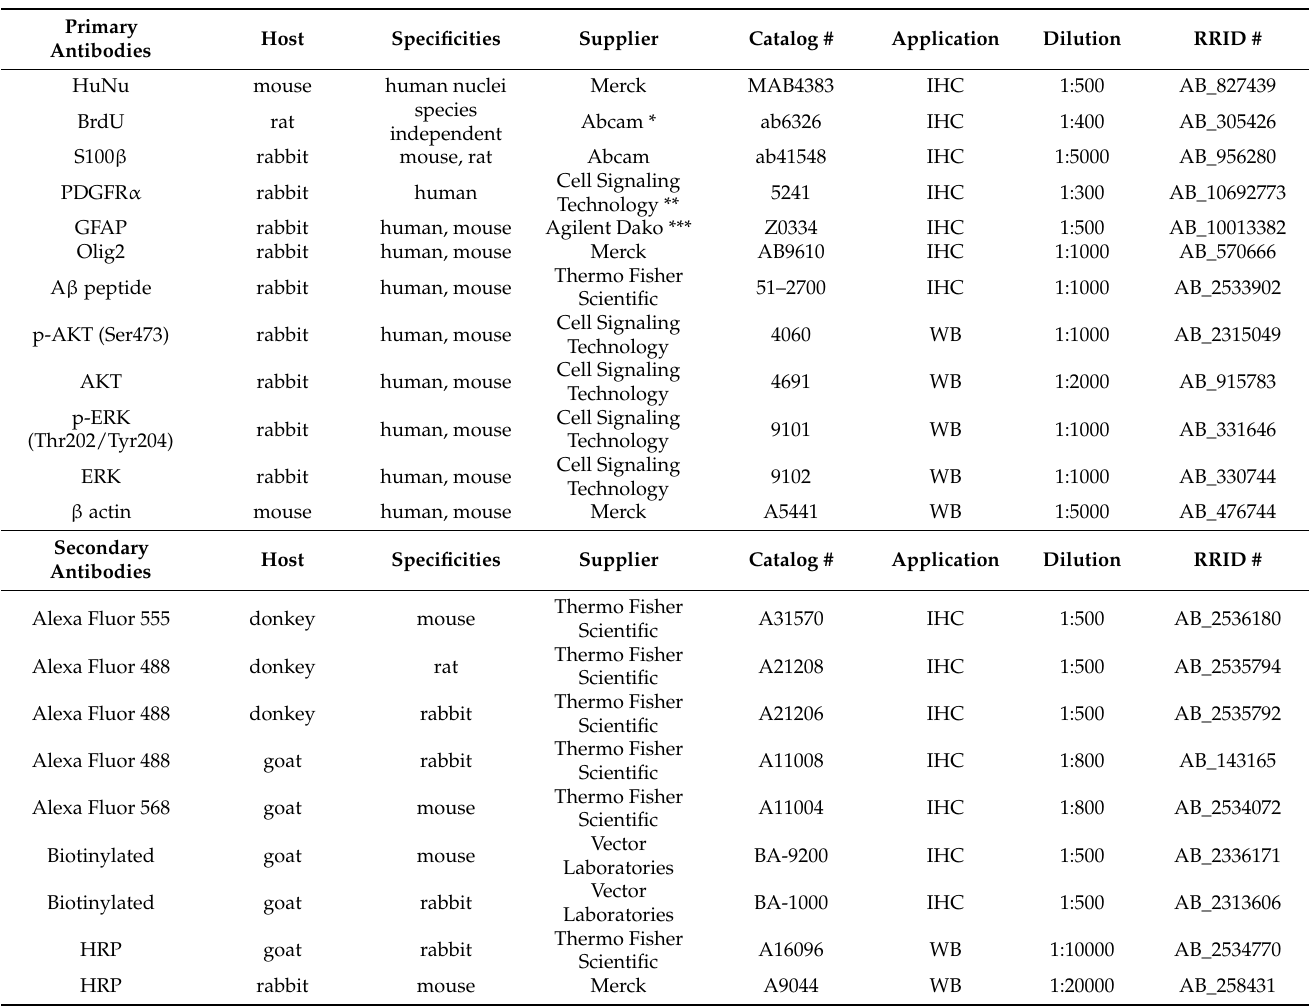
Table 4. Summary of the antibodies used in this